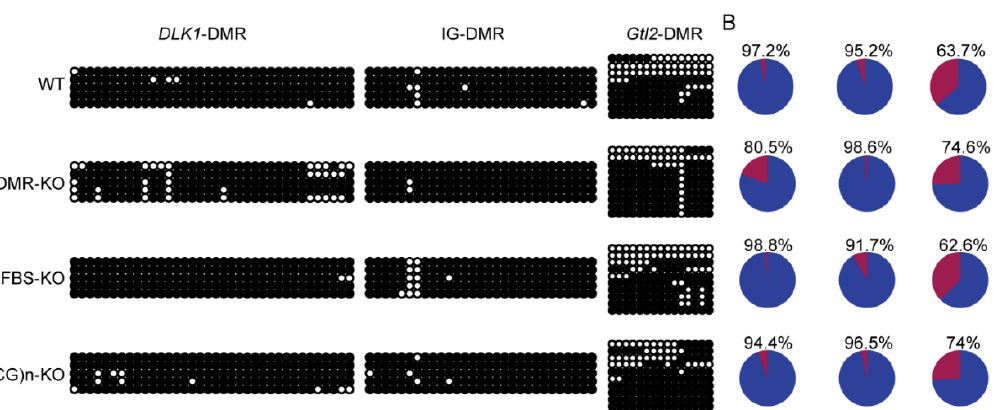
Figure 7. Methylation of the Dlk1-Dio3 domain in the absence of Meg8 -DMR. ( A ) Bisulfite sequencing analysis of Dlk1 -DMR, IG-DMR , and Gtl2 -DMR in each cell line. Each CpG dinucleotide is represented with a circle. Each row of circles represents an individual clone sequenced. Black and white circles represent methylated and unmethylated CpGs, respectively. ( B ) Percentage statistics of methylation status.